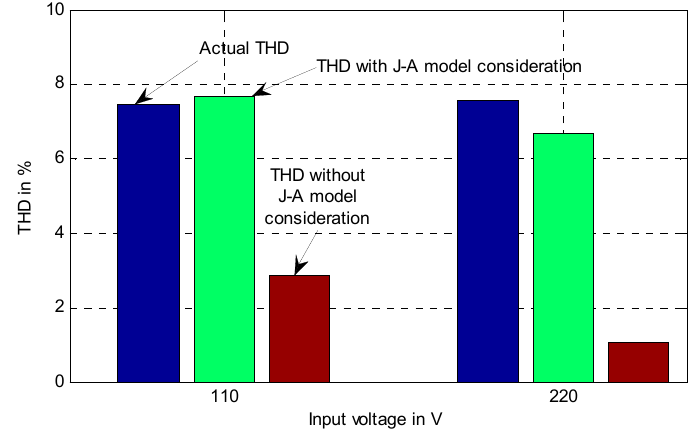
Figure 13. Input current THD analysis result with, and without, J-A model